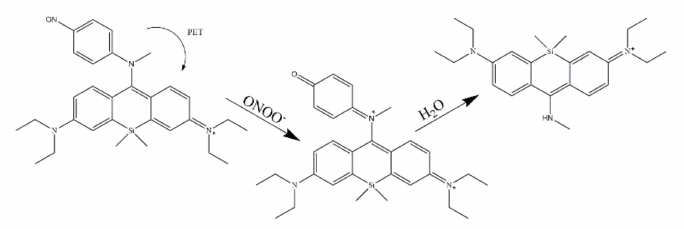
Figure 45. The proposed sensing mechanism of SiNH (Table 3, No. 8) [97]. Sensors for SH − and ClO − are useful in the environment and biosafety. SH − is a highly toxic material and harmful to the environment, humans, and animals [102,103], and ClO − is a toxic disinfection by-product of hypochlorite salts [104], often used as a disinfectant in swimming pools and other water environments [105]. SH − sensor (Table 3 No. 9) [98] and ClO − sensors (Table 3 No. 10–11) [99,100] were applied to detect environment water samples and living cells, and both were convenient for monitoring human and animal health. Wu J., et al. chose the DNBS group as a cleavable quencher of rhodamine-based fluorescence since thiophenols removed the group and recovered the rhodamine fluorescence [98]. The sensing mechanism was attributed to the nucleophilic substitution reaction of thiophenols (Figure 46) and confirmed by HPLC.